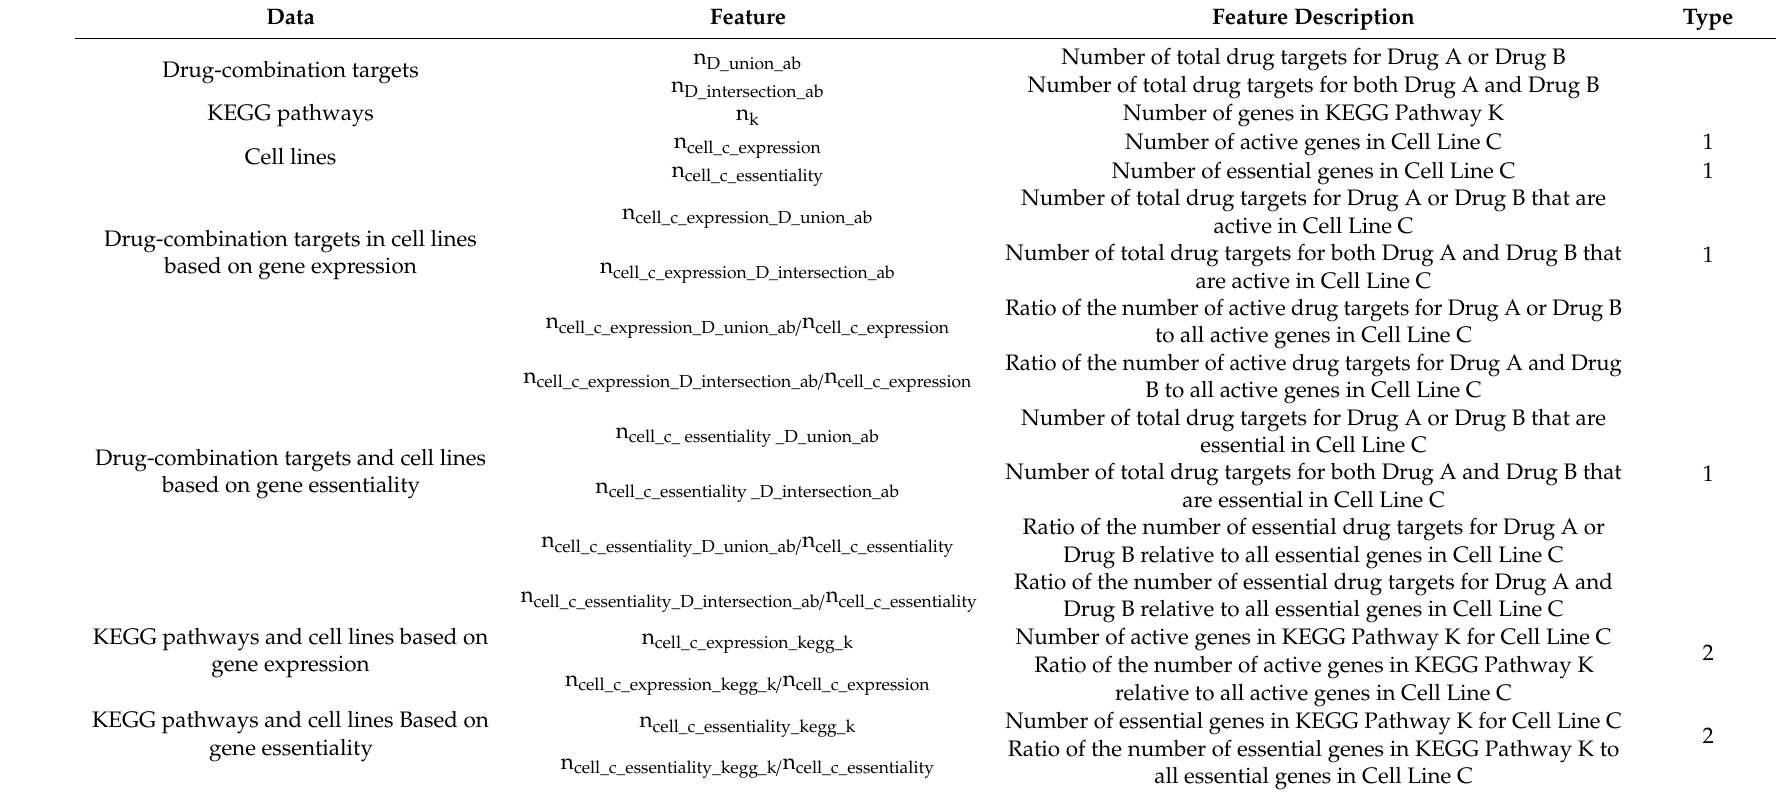
Table 1. Definitions of pathway features in the